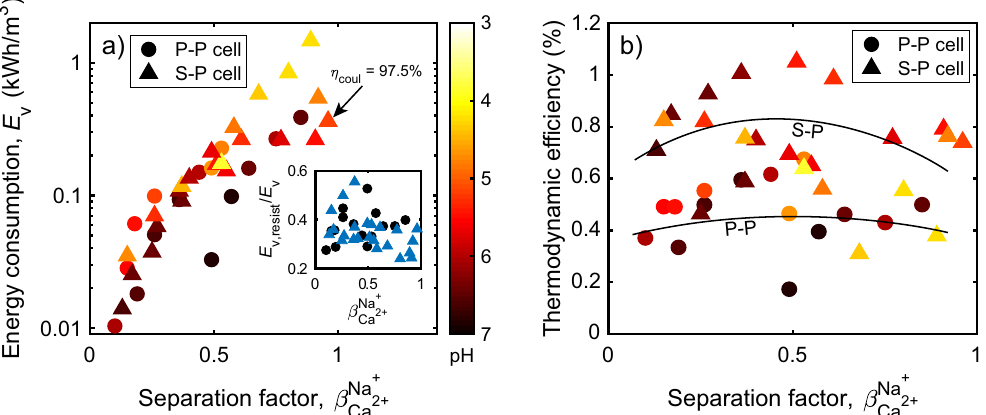
Fig. 6 Measured energy consumption, E v , and thermodynamic energy ef fi ciency (TEE), for the case of zero energy recovery. Marker color indicates the product water pH. a Measured energy consumption per m 3 of product water. Coulombic ef fi ciency is indicated for the point with ¼ 0 : 96 (experimental parameters of 1.2 V, 6 min FCT), which consumed 0.36 kWh/m 3 . Inset shows the fraction of total energy use lost to β Na þ Ca 2 þ resistive dissipation, E v,resist / E v , vs. separation factor. b TEE of the data shown in panel a , where lines are meant to guide the